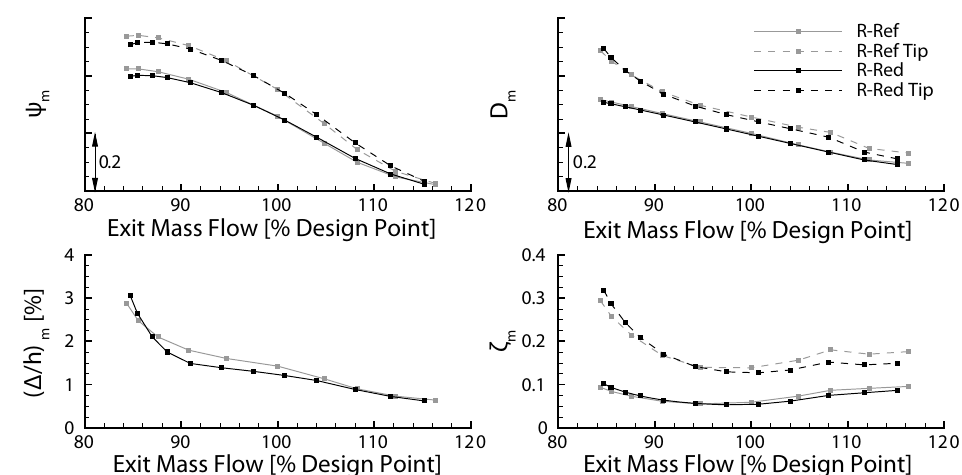
Figure 3. Aerodynamic Behavior of R-Ref and R-Red